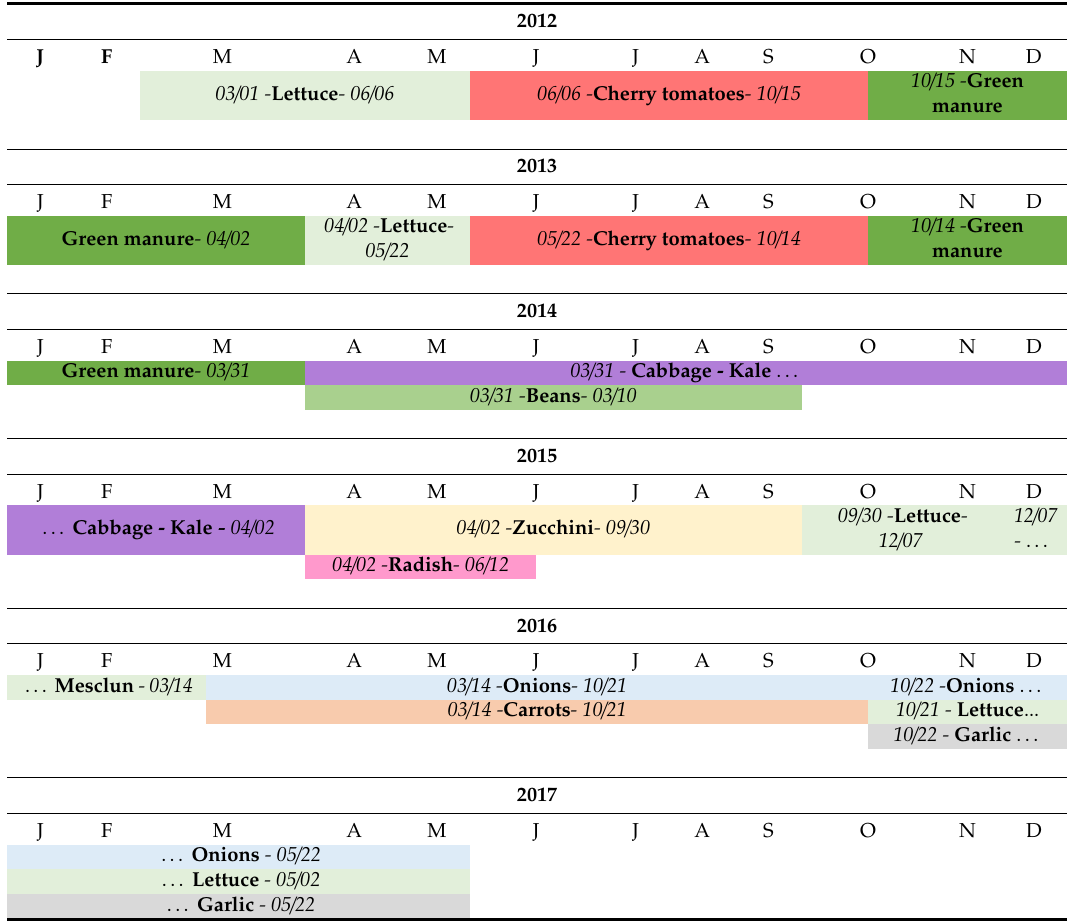
Table 2. Calendar of the crop rotation